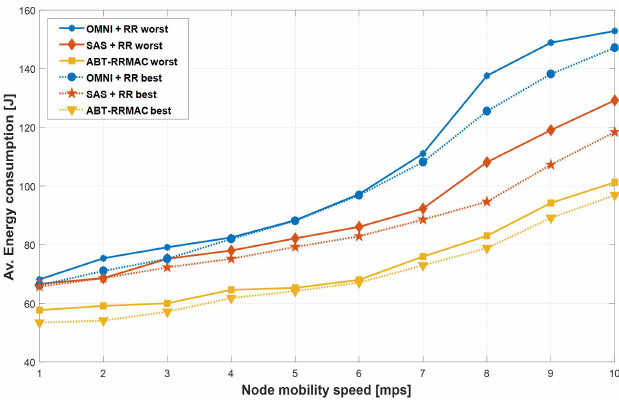
Figure 11. Energy consumption vs. node mobility